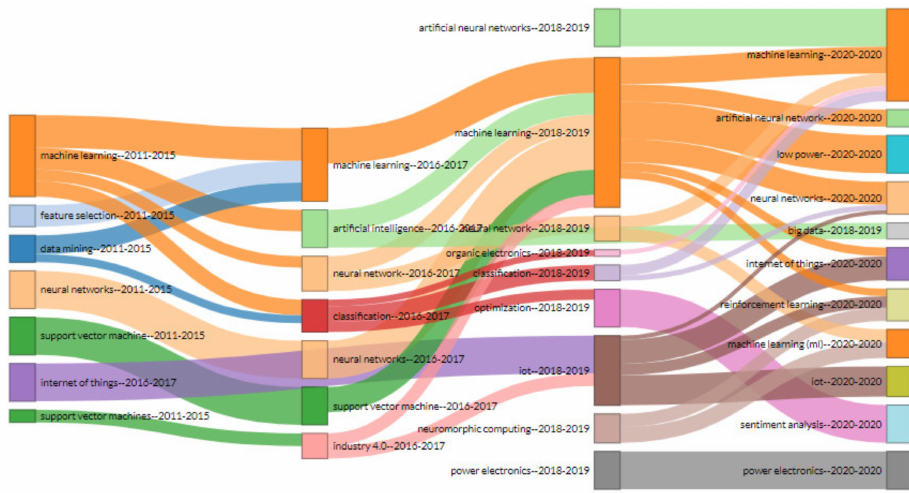
Figure 12. Thematic